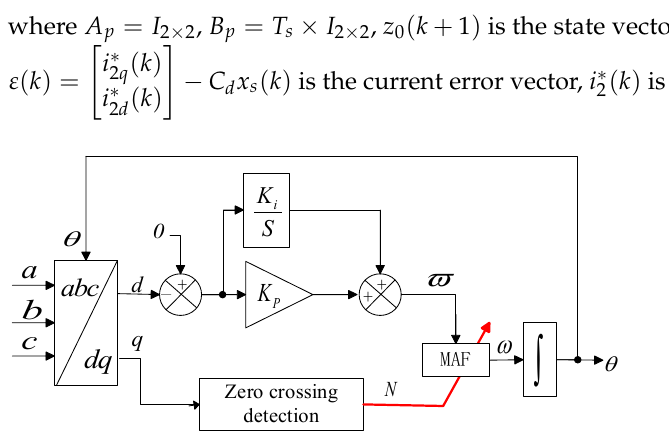
Figure 2. Configuration of the MAF-PLL scheme.